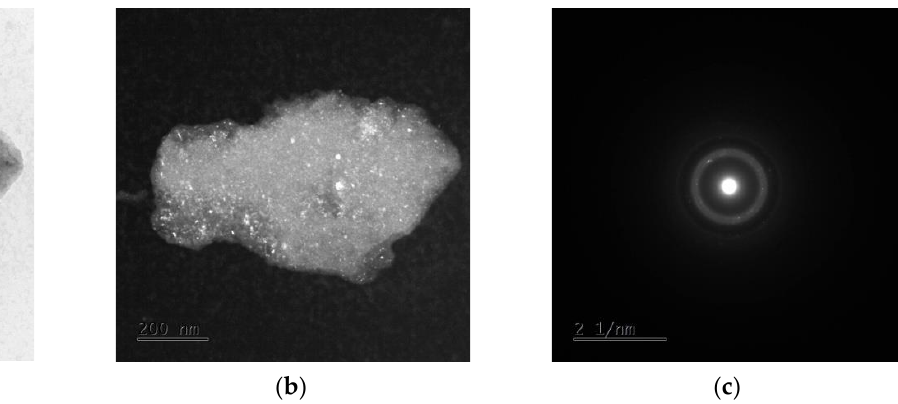
Figure 8. TEM images for Mg 65 Zn 30 Ca 4 Ag 1 milled for 70 h. ( a ) Bright field image, ( b ) dark field im- age, ( c ) SAED pattern from tested region.